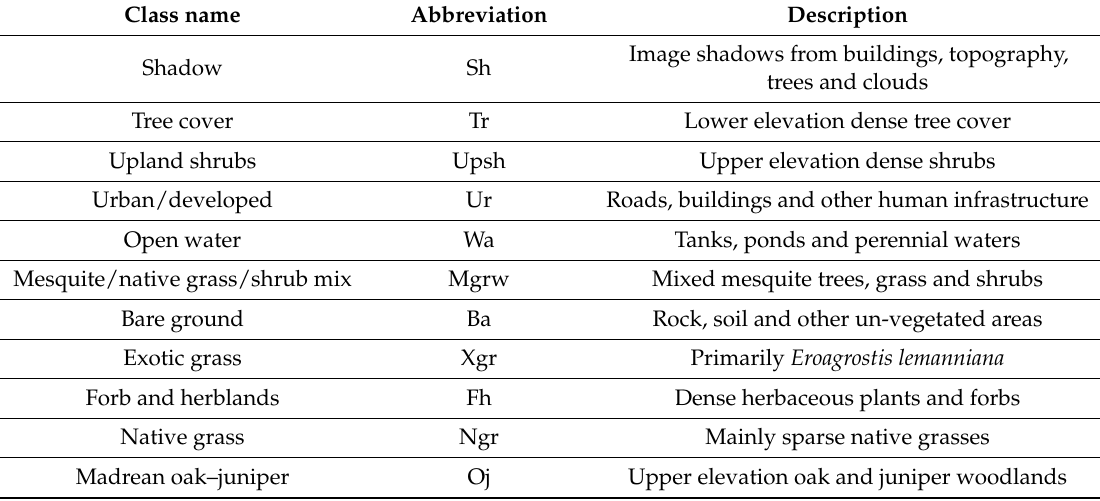
Table 2. Land cover class descriptions and abbreviations used for mapping fuel-types on Buenos Aires National Wildlife Refuge